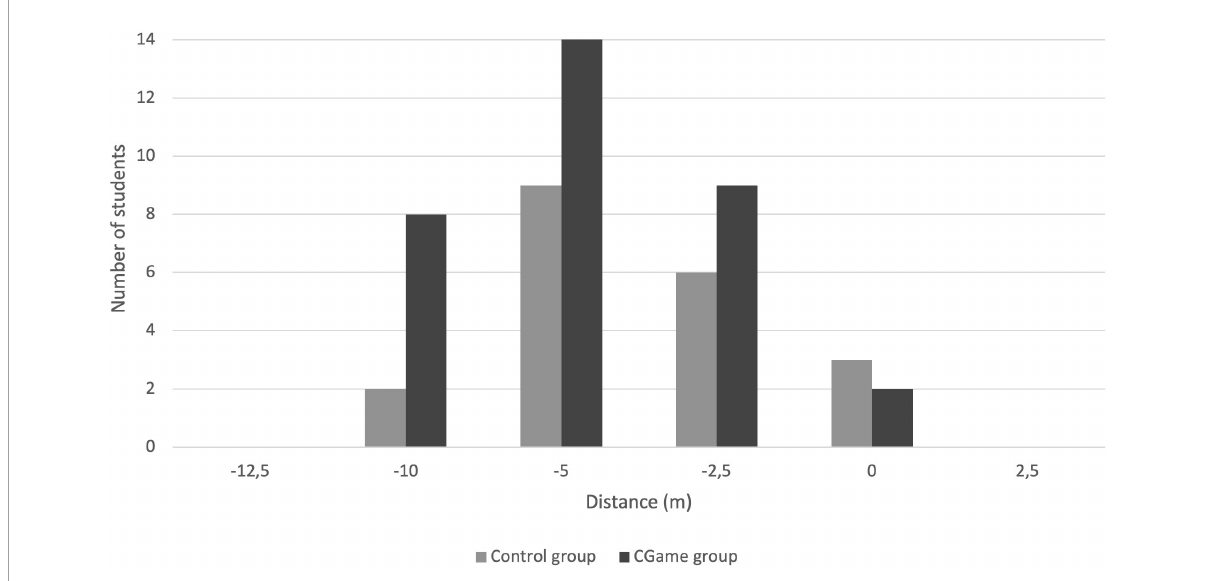
FIGURE1 Difference of distance at pre-test apneas between estimation and the real distance performed for both groups. Vertically, the number of swimmers. Horizontally, the distance is in meters. The homogeneity test confirms that the groups can be considered as belonging to the same population (Chi 2 = 2.78, dof = 1, r = 0.1, NS). They are only underestimated, most often 5 m below the estimated distance.